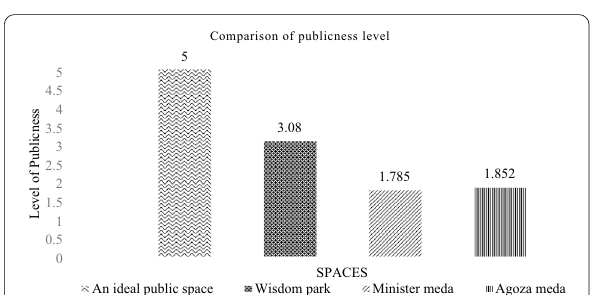
Fig. 5 Comparison between an ideal public space and open spaces at Kebena